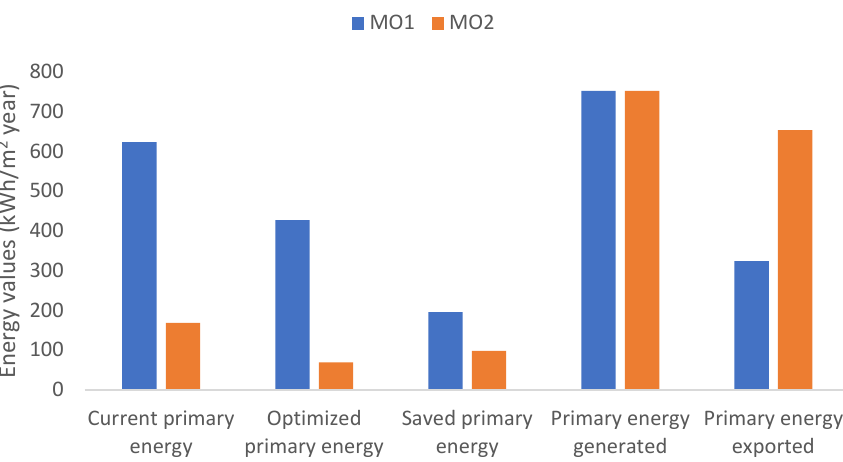
Figure 12. Comparison of Primary energy values obtain in both models.